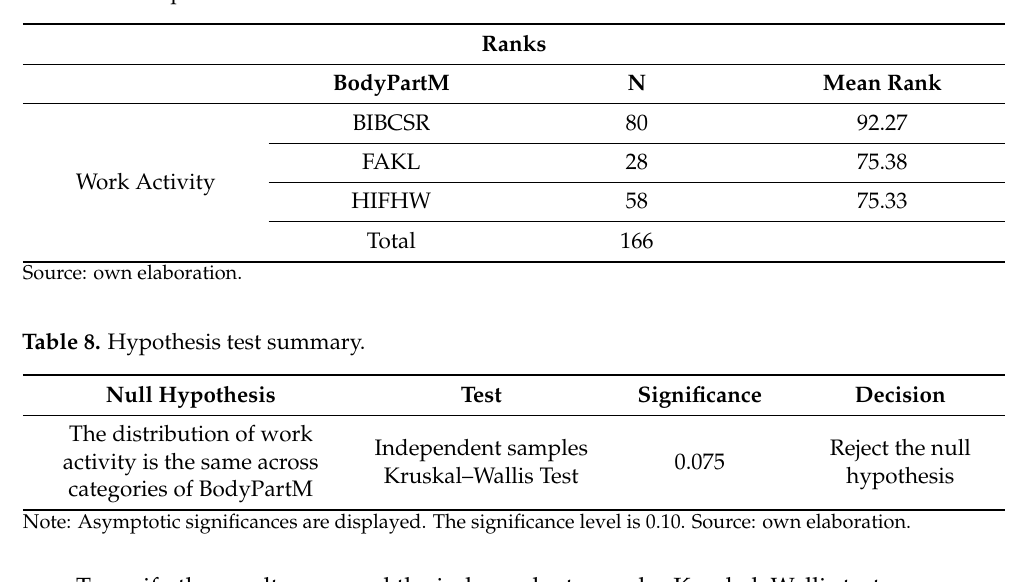
Table 7. Descriptive statistics: means.